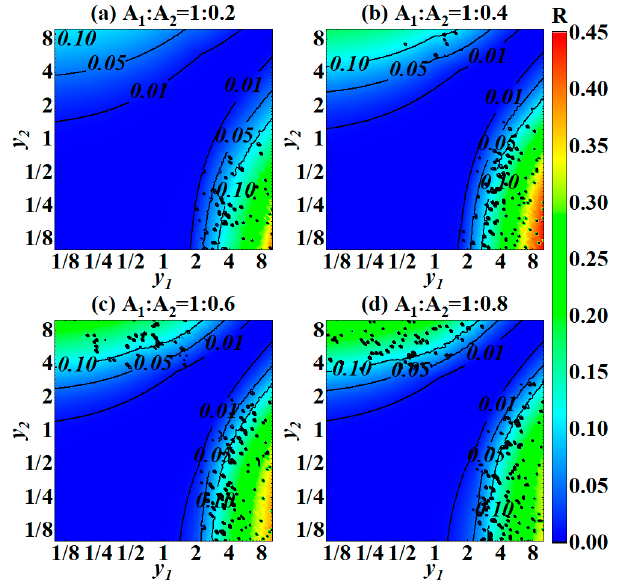
Figure 4. Distribution of the absolute value of the IA error for u = x (cid:48) 1 / x (cid:48) 2 = 1 and different values